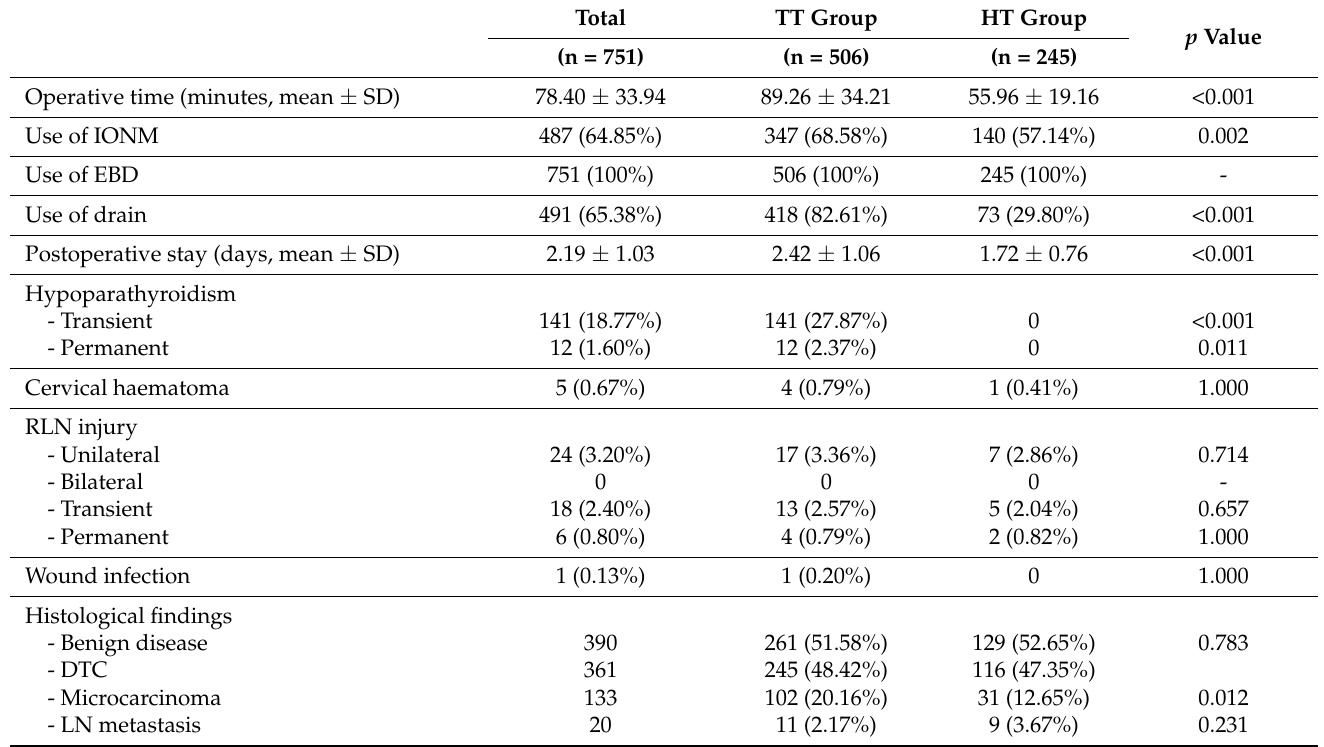
Table 2. Information about surgical procedure, postoperative stay, complications and histological findings regarding the whole sample, TT Group and HT Group.